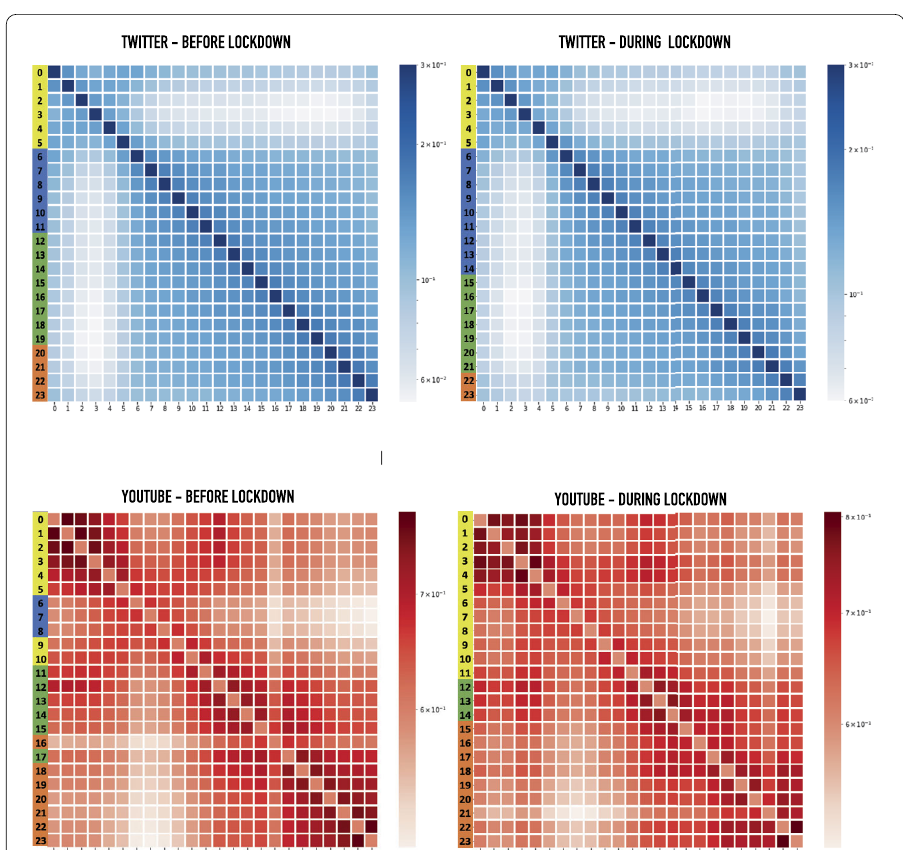
Figure 5 Hours Correlation. Heat-maps of the content hour similarity before and during the lockdown for Twitter and YouTube. The colors of the hours on the left of the graph represent the partition of the k-means